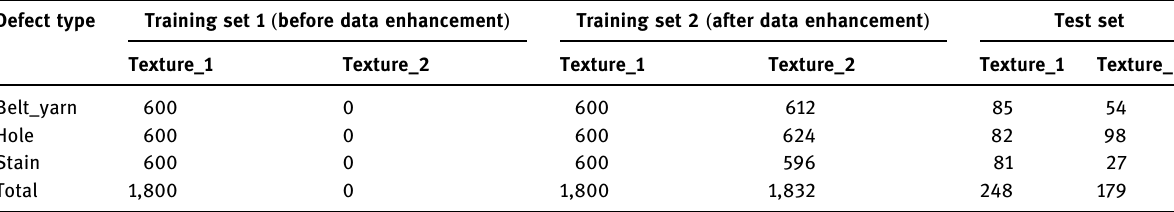
Table 2: The number of image samples in the datasets Defect type